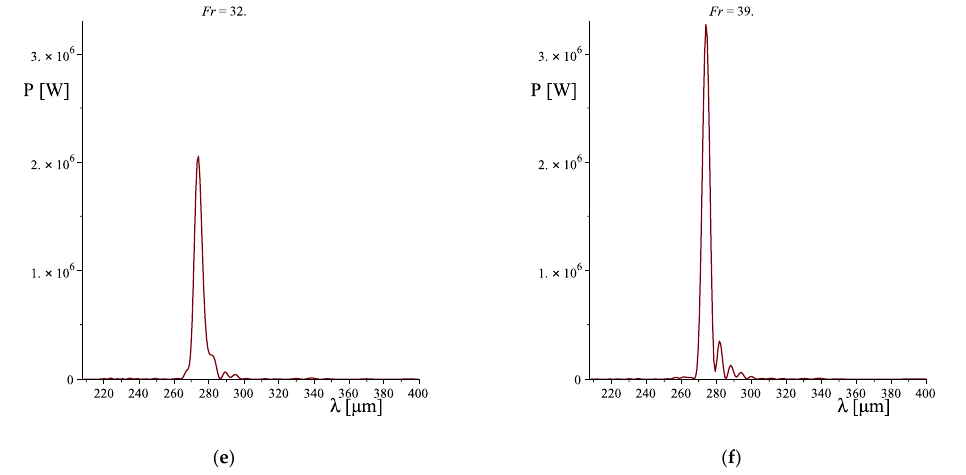
Figure 7. Power spectrum for different drift-space values: ( a ) L Drift = 0.18 m; ( b ) L Drift = 0.90 m; ( c ) L Drift = 1.52 m; ( d ) L Drift = 2.15 m; ( e ) L Drift = 2.87 m; and ( f ) L Drift = 3.50 m.